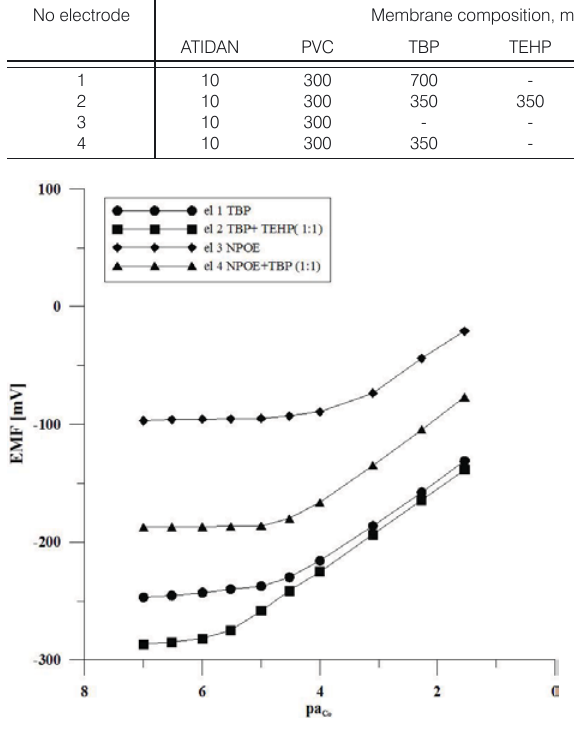
Figure 3. Effect of plasticizer on potential response of electrodes based on